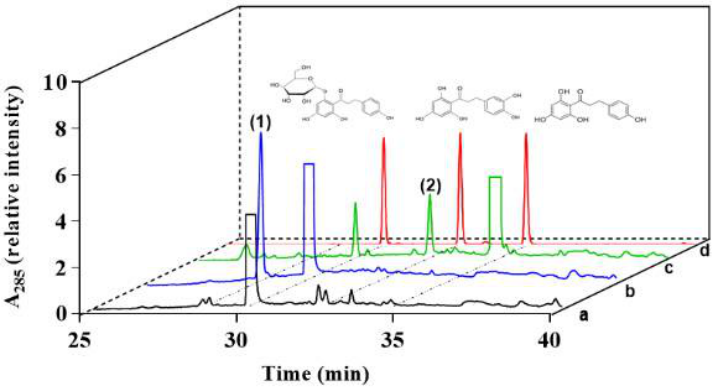
Figure 5. HPLC chromatograms of phlorizin and its major product produced by CYP102A1 M371.